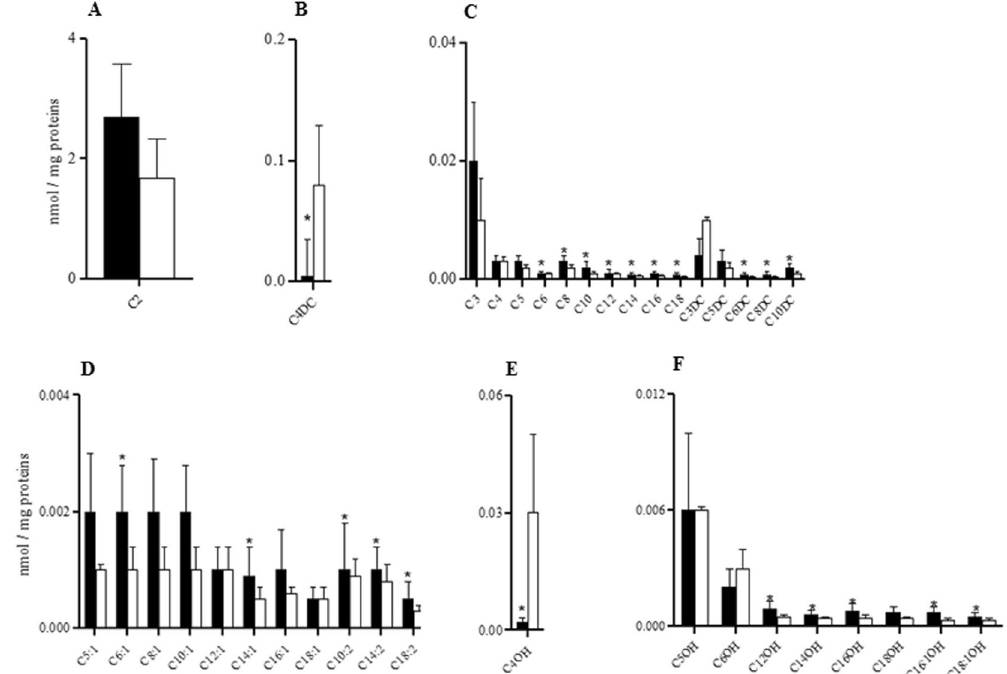
Figure 5. Inter-sex analysis of AC levels (nmol/mg protein) in male (M) and female (F) rat hearts. Values are the medians ± MAD of 15 independent samples for each sex. * P < 0.05 versus